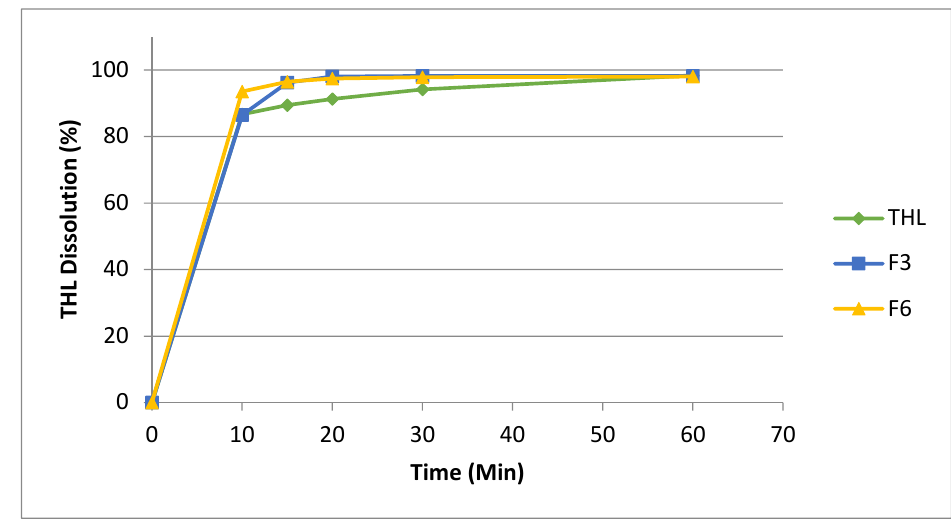
Figure 9. Dissolution profiles bulk THL, THL-NIC cocrystals extruded at 0.5 kg/h (F3) and cocrystals extruded at 1.5 kg/h (F6).